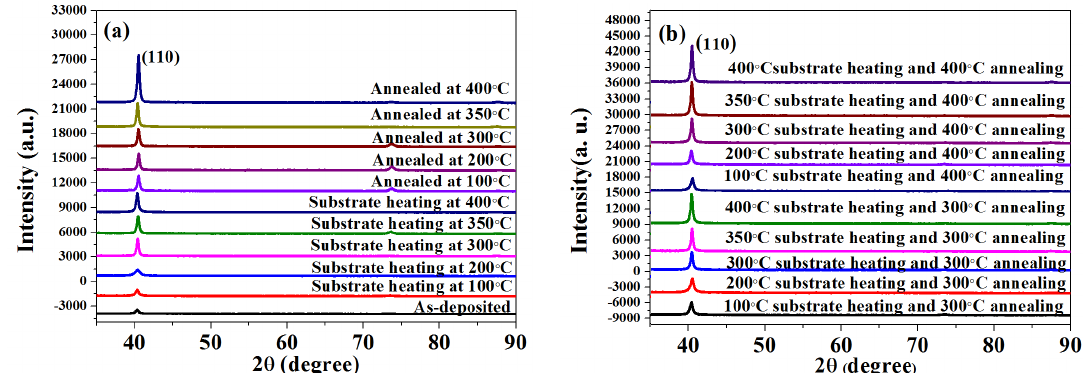
Figure 1. X-ray diffraction patterns of the Mo films heated ( a ) at various substrate temperatures and annealing temperatures and ( b ) at various substrate temperatures, then annealed at 300 °C and 400 °C. It is worth discussing that the peak position shifts as the heating modes and temperature change.